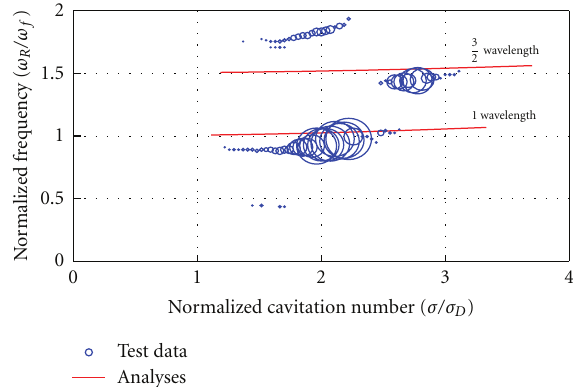
Figure 11: Comparison of frequency between experimental results and analytical results of the model in which valve resistance is considered, supposing K drag = 0, K drag V = 125.